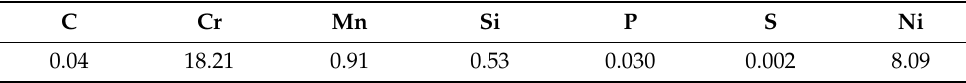
Table 4. Chemical compositions of SS 304 in wt.% (JIS G4313).